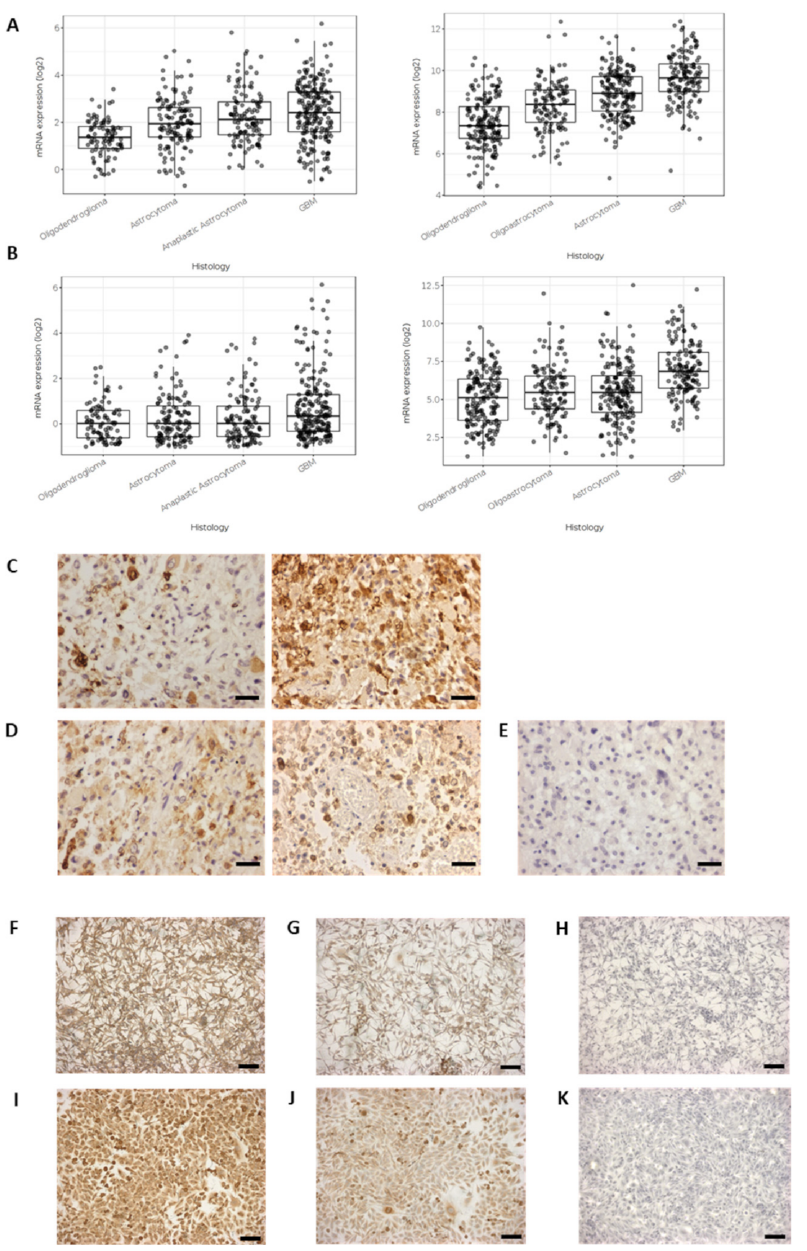
Figure 1. Cyclooxygenase expression in gliomas. ( A ) PTGS1 (COX1) mRNA expression in gliomas using Gliovis software for analysis, TCGA and CCGA datasets; ( B ) PTGS2 (COX2) mRNA expression in gliomas using Gliovis software for analysis, TCGA and CCGA datasets; ( C ) COX1 immunohis- tochemistry reaction in GBM tissue sections; ( D ) COX2 immunohistochemistry reaction in GBM tissue sections; ( E ) Negative control reaction in GBM tissue section; ( F ) COX1 immunocytochemistry in U87MG cells; ( G ) COX2 immunocytochemistry in U87MG cells; ( H ) Negative control, U87MG; ( I ) COX1 immunocytochemistry in U251MG cells; ( J ) COX2 immunocytochemistry in U251MG cells; ( K ) Negative control, U251MG. Scale bar in ( C – E ) = 30 µ m; scale bar in ( F – K ) = 50 µ